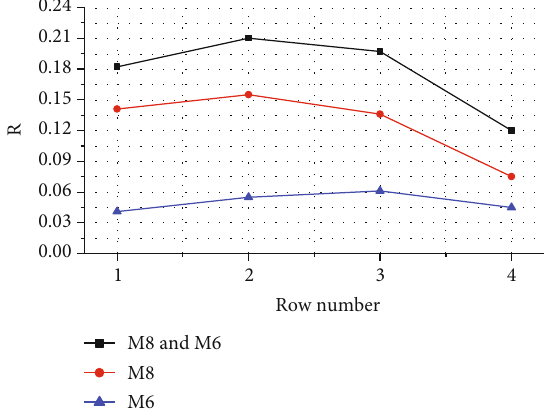
Figure 17: The force distribution coe ffi cient R between four rows of